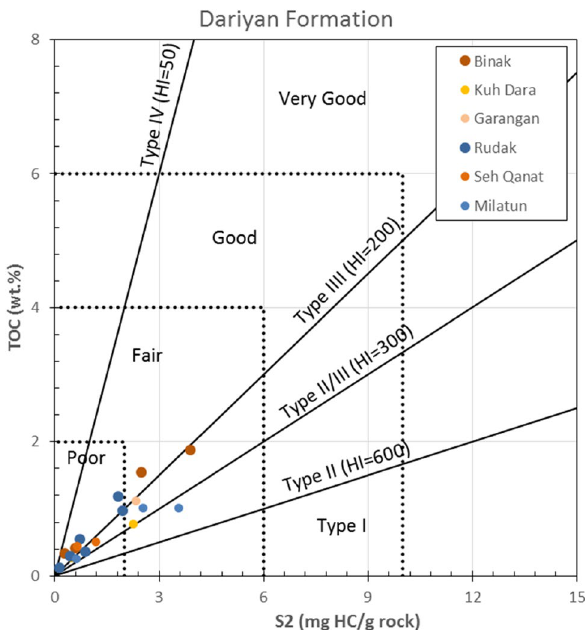
Fig. 10 S2 versus TOC diagram of the Dariyan Formation based on available samples from the South Dezful Embayment (after Dahl et al. 2004)